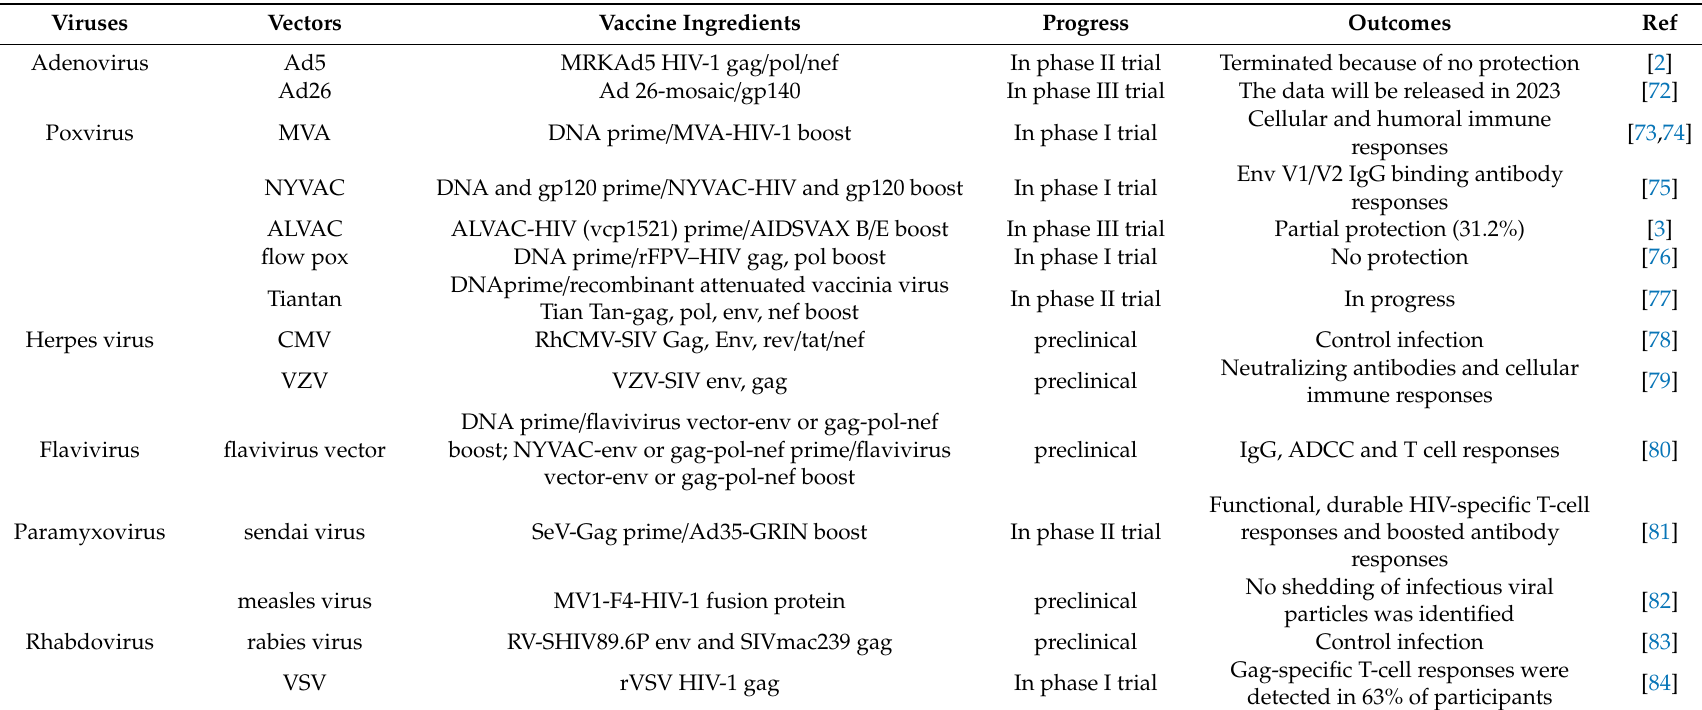
Table 2. Summary of promising viral vectored HIV-1